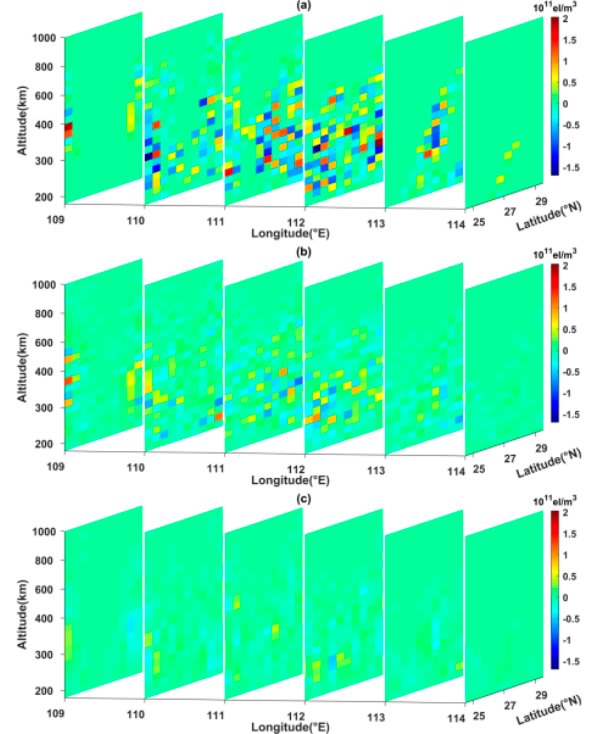
Figure 4. Reconstructed error comparison of the three algorithms along different longitudinal